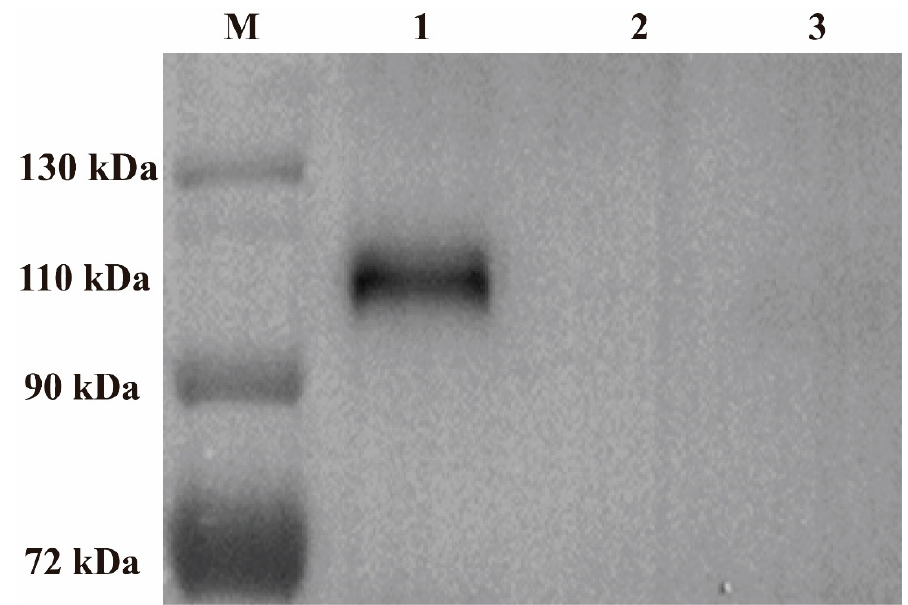
Figure 3. Expression of the gB gene in rFPV by Western blot. CEF cells were infected with rFPV-gB or wt-FPV at MOI of 0.1. The infected cells were harvested at 48 h post-infection, and then mixed with the sodium dodecyl sulfate (SDS) sample buffer and boiled for 10 min. Expression of ILTV gB was determined with the chicken polyclonal antibody against the gB gene of ILTV by Western blot. M: Marker, 1: rFPV-gB, 2: wt-FPV, 3: Mock CEF cells.